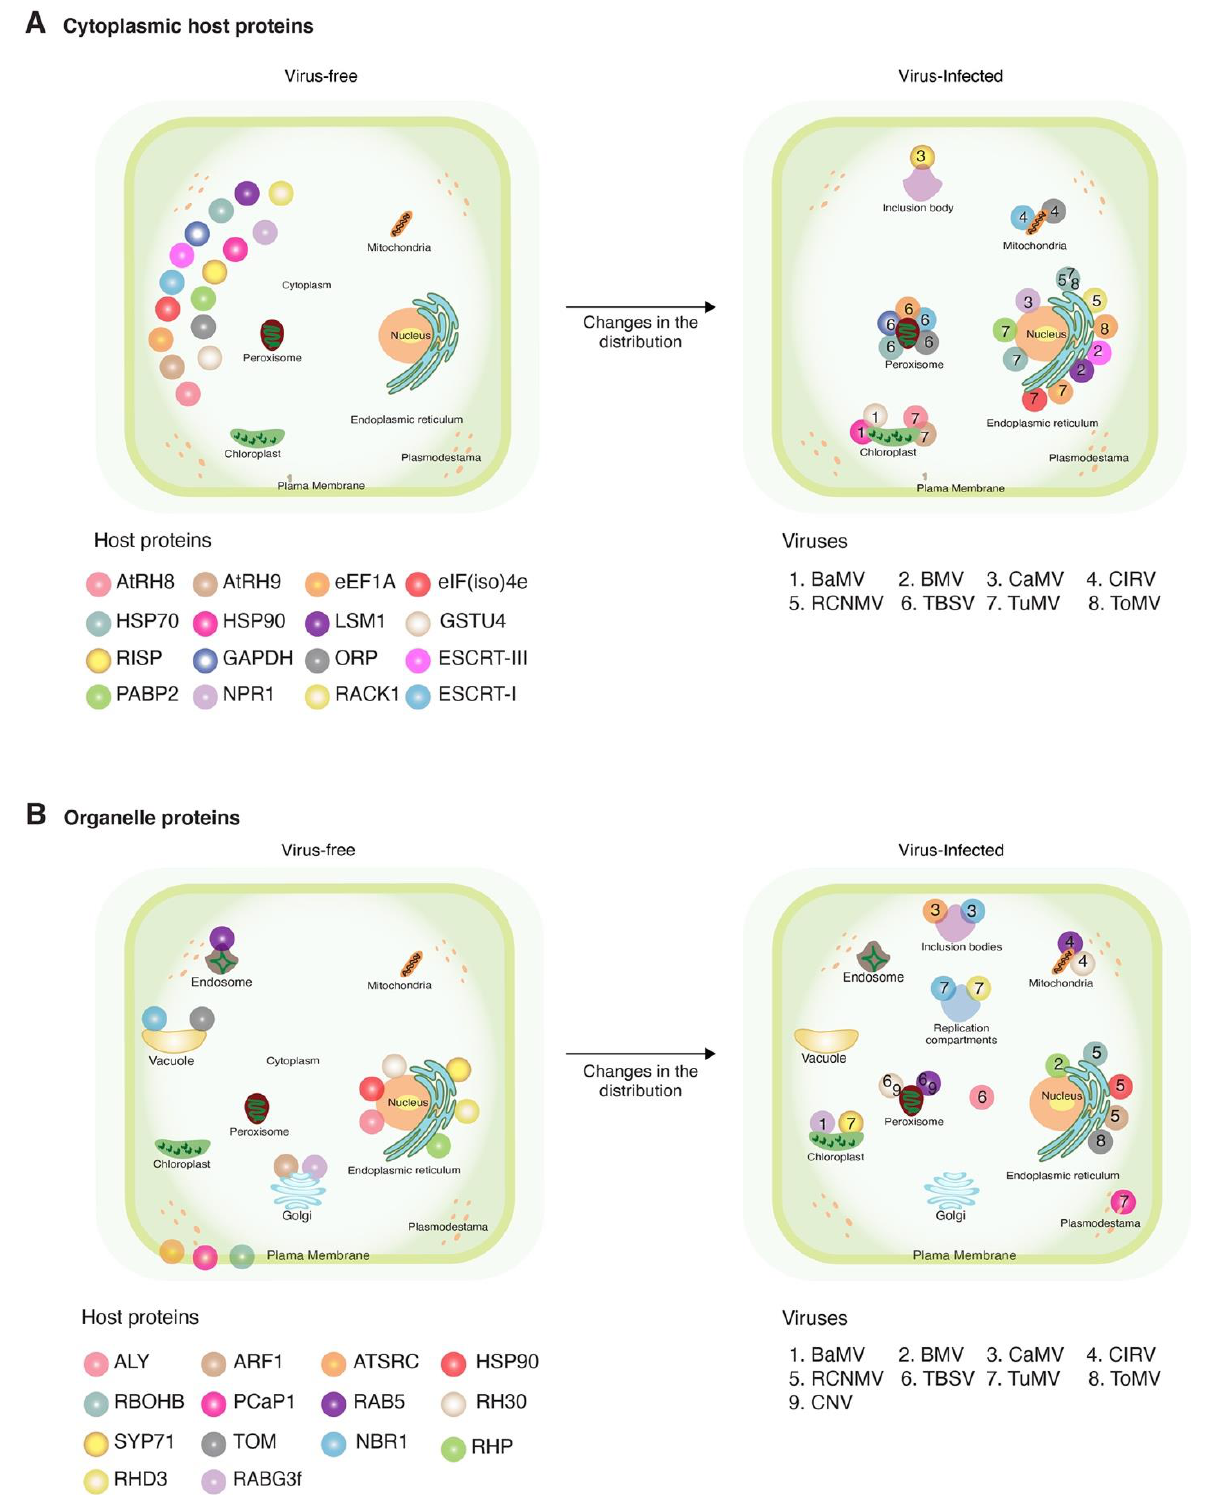
Figure 2. Schematic representation of changes in subcellular localization after viral infection. Representative host proteins and plant viruses that induce relocation in more than two proteins are illustrated. Host proteins are color-coded with spheres. Viruses are indicated by numbers. ( A ) Changes in host cytoplasmic proteins and ( B ) changes in host proteins naturally localized to organelles, and their movement in the presence of a virus.